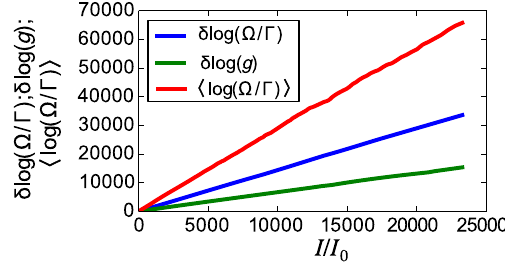
FIG. 3. Scaling of the coupling constants (averages and standard deviations) with block length at the critical point. The linear growth of the scaling variables with the length indicates a flow to infinite